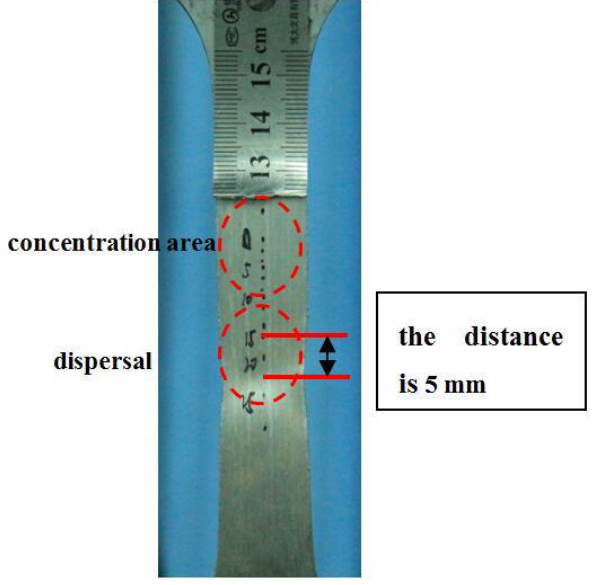
Figure 8. Comparison of the test results of specimens O1 and O2.